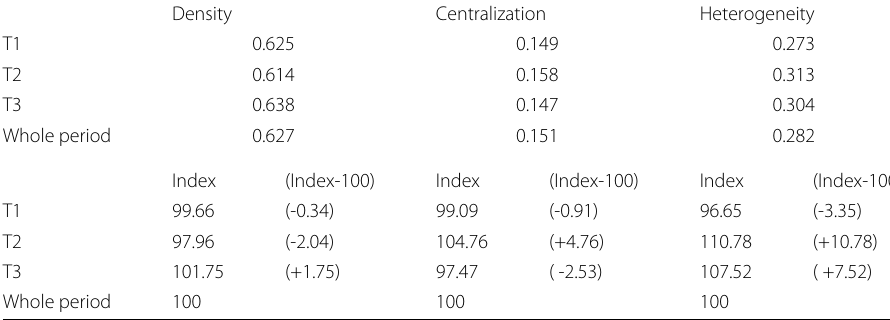
97.47 ( +7.52) Whole period 100 100